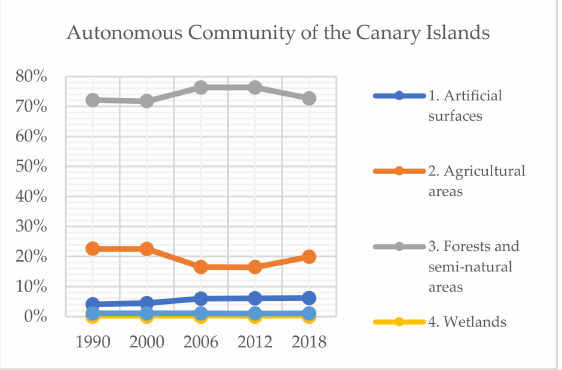
Figure 13. Percentage of land-uses according to level 1 of CLC nomenclature in the Autonomous Community of the Canary Islands.